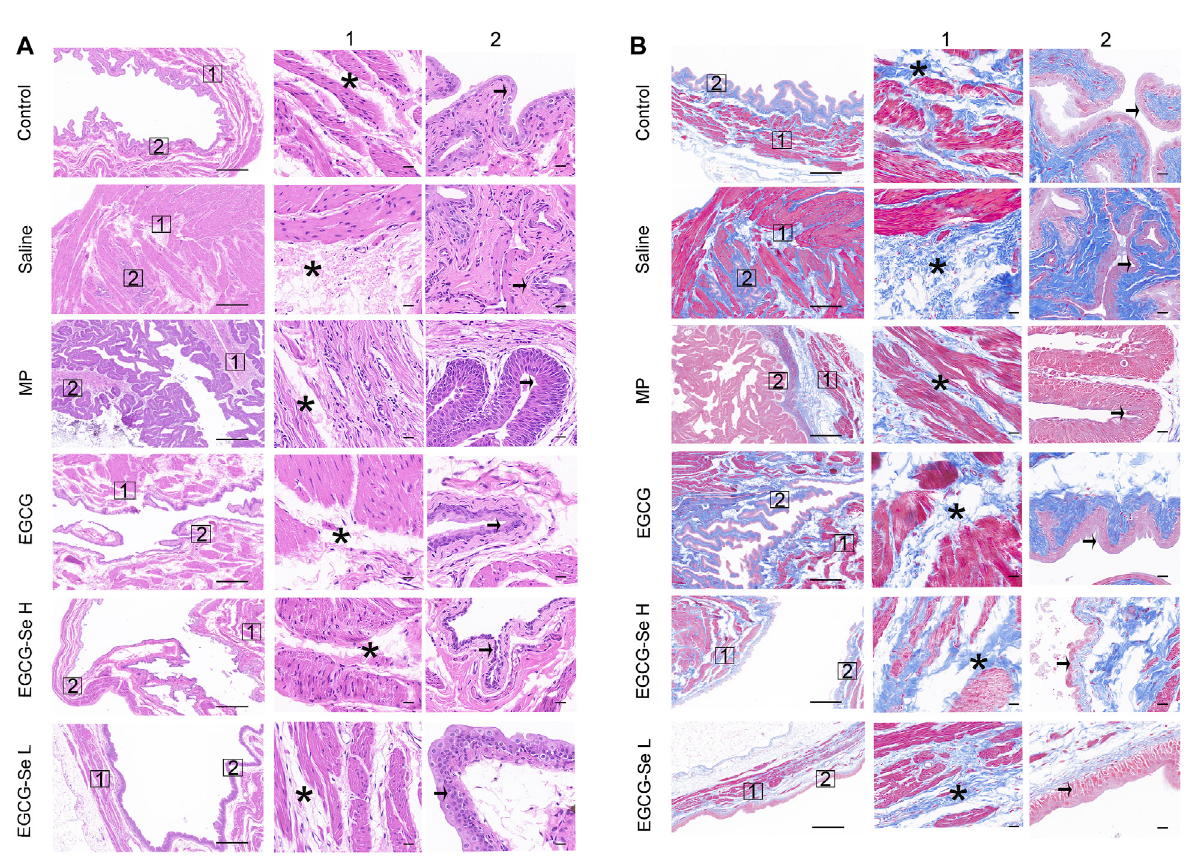
FIGURE 5 Hematoxylin-eosin (H and E) and Masson staining of bladders. (A) Representative bladders stained with H&E. Columns 1 and 2 are magni fi cations of the areas marked by the blue squares in the left column. Pathological changes of the bladder are indicated using asterisks (muscle layer) and arrows (intima). Scale bars are 500 and 50 μ m, respectively. (B) Representative bladders stained with Masson stain. Columns 1 and 2 are magni fi cations of the areas marked by the blue squares in the left column. Pathological changes of the bladder are indicated using asterisks (muscle layer) and arrows (intima). Scale bars are 500 and 50 μ m,